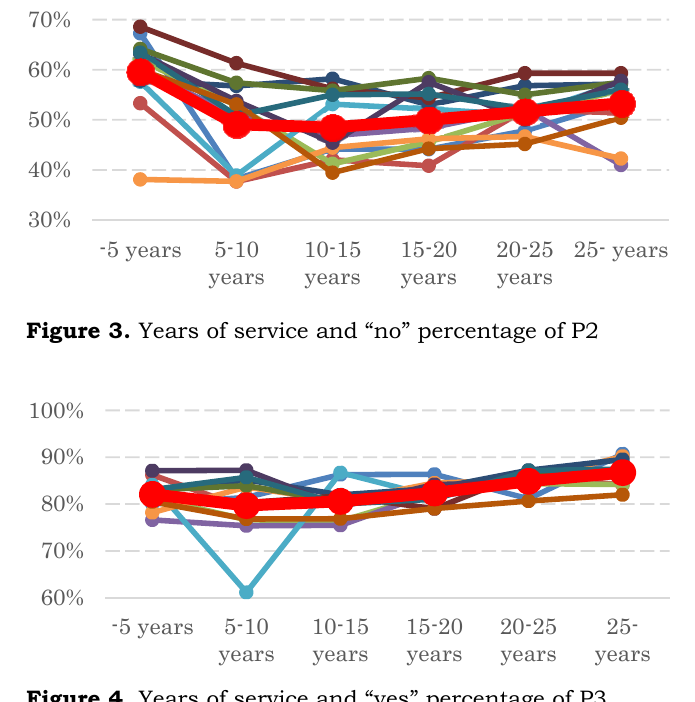
Figure 4. Years of service and “yes” percentage of P3